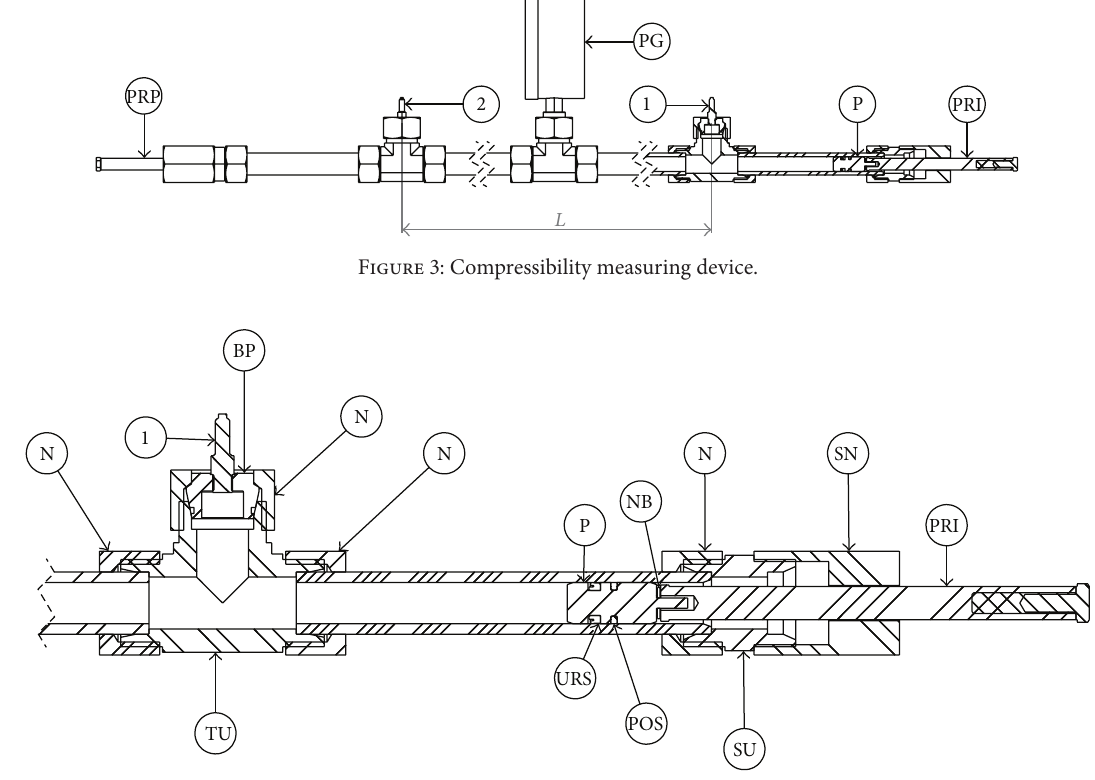
Figure 4: Cross-section of the compressibility measuring device.